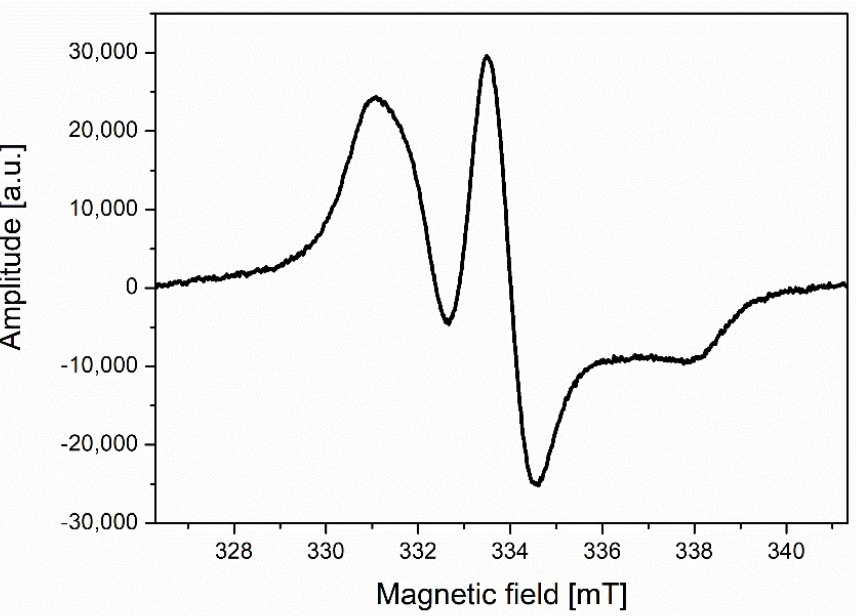
Figure 9. ESR spectrum of TEMPO spin probe with yeast cells in the presence of vitamin C recorded at 240 K (incubation time 10 min).